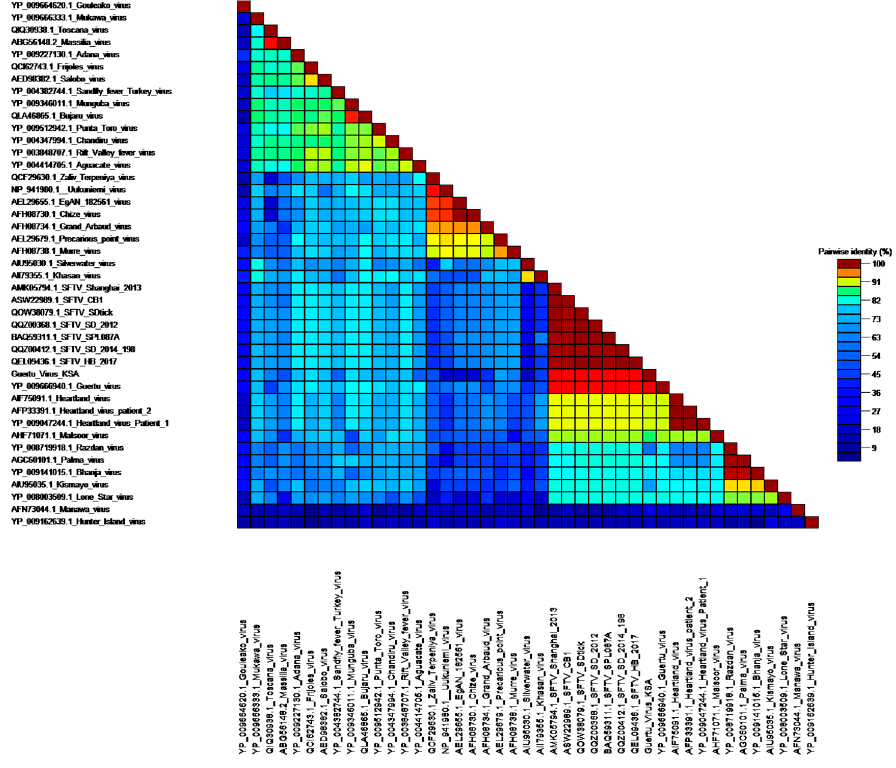
Figure 4. Pairwise protein identity matrix of Phenuiviridae S segment including new Guertu strain identified in Saudi Arabia.